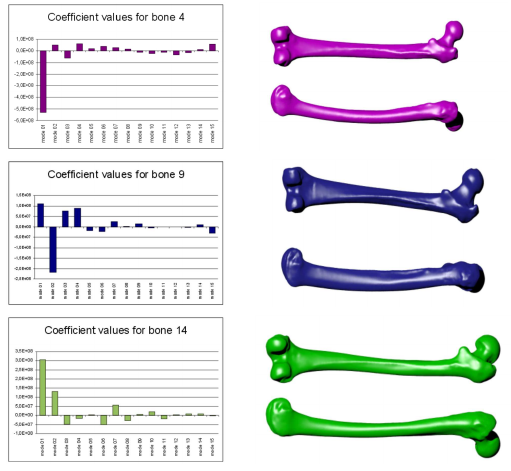
Figure 9. Correlation between coefficient value and geometry of the bone for three different femur bones (all pictures of bones are made in the same